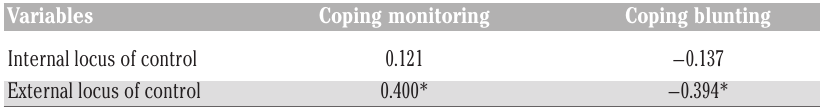
Table 4. Experimental group: correlations between children’s coping strategies and their locus of control (Pearson correlation Coefficient).